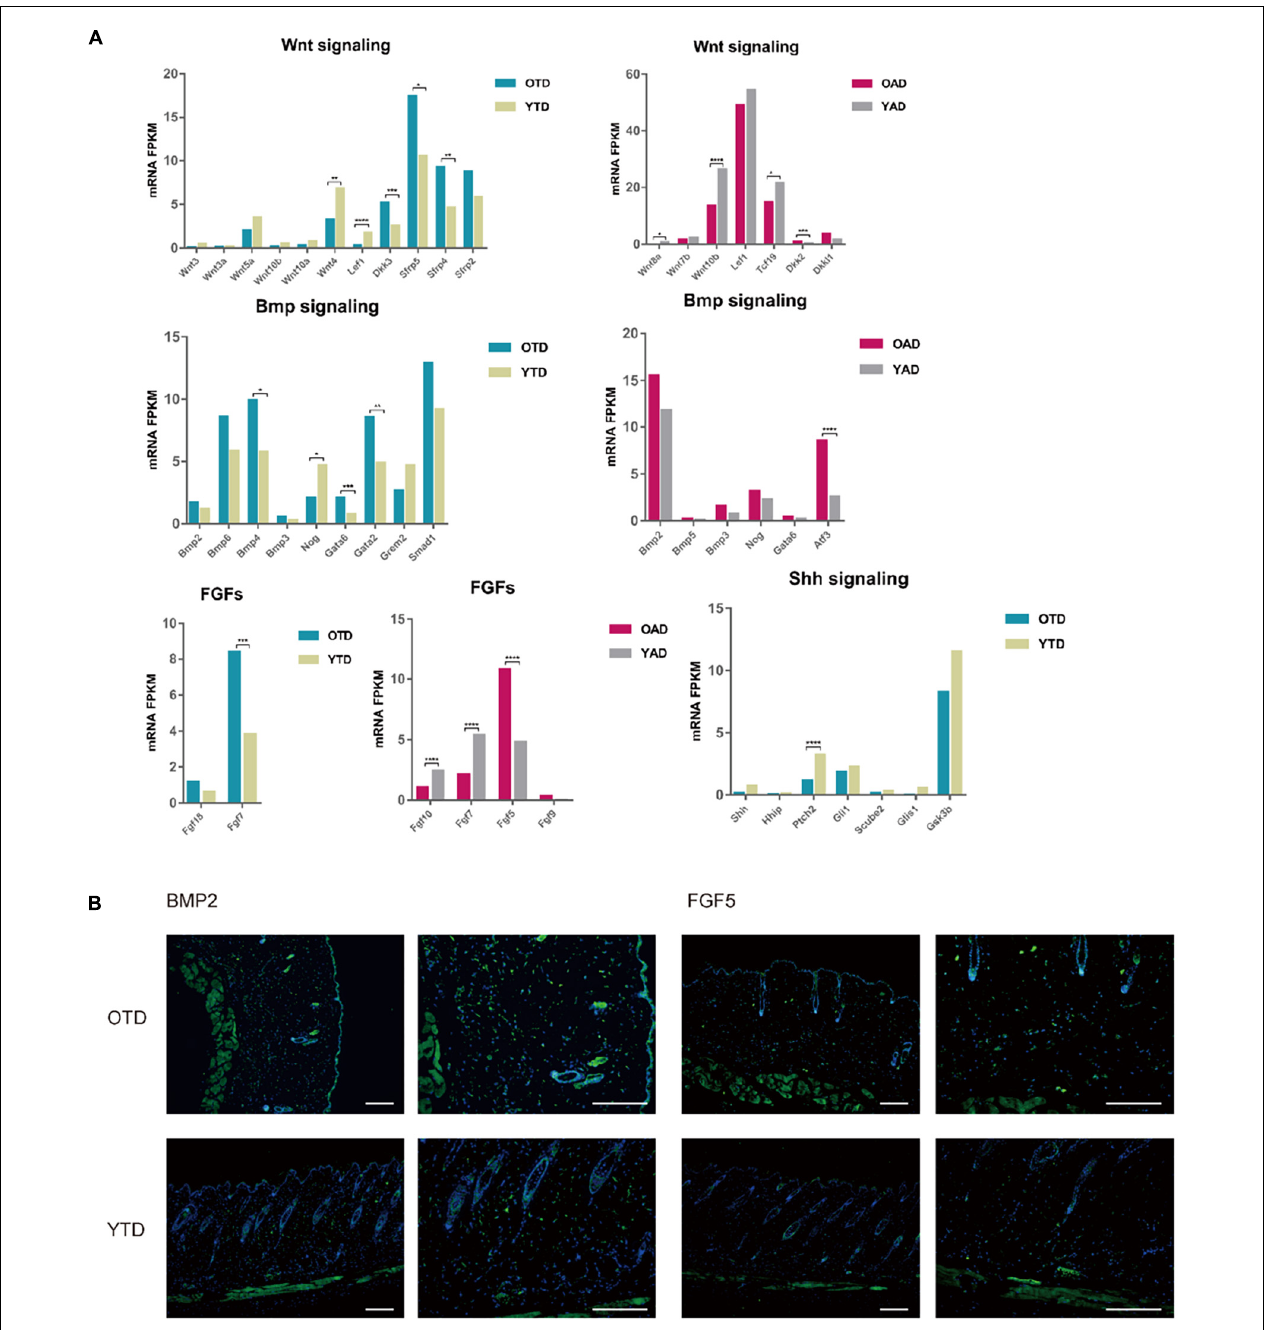
FIGURE 4 | Aging dWAT negatively modulated HF behaviors. (A) Essential growth signaling for HF development indicated abnormal expressions in aging dWAT, including WNT, BMP, and FGFs. SHH-related signaling showed little changes. (B) BMP2 and FGF5 indicated overexpression in aging dWAT. Scale bars = 100 µ m. * P < 0.05, ** P < 0.01, *** P < 0.001, and **** P <